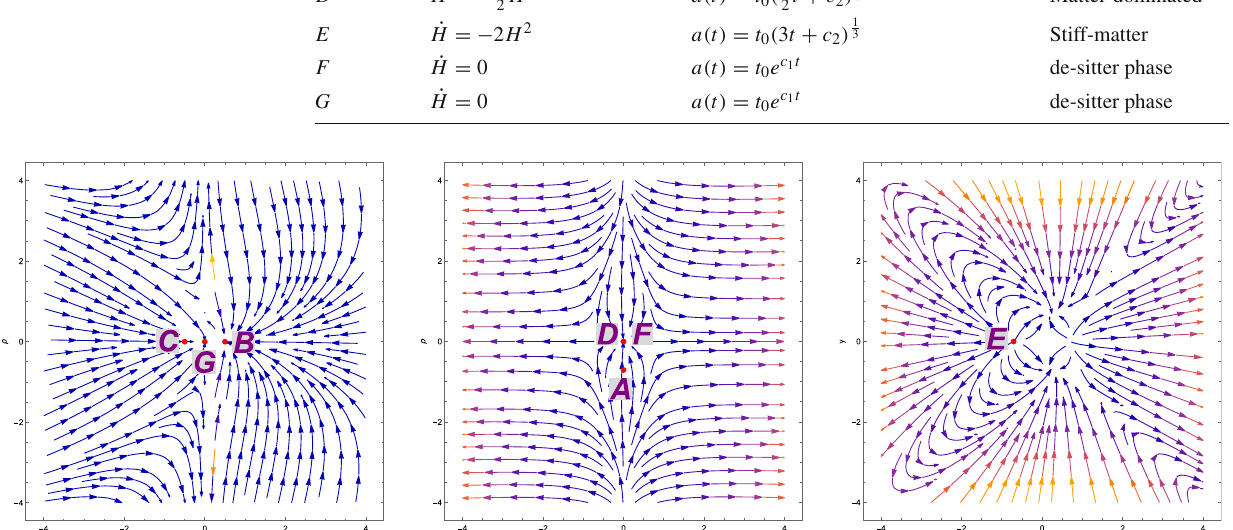
Table 6 Cosmological solutions of critical points